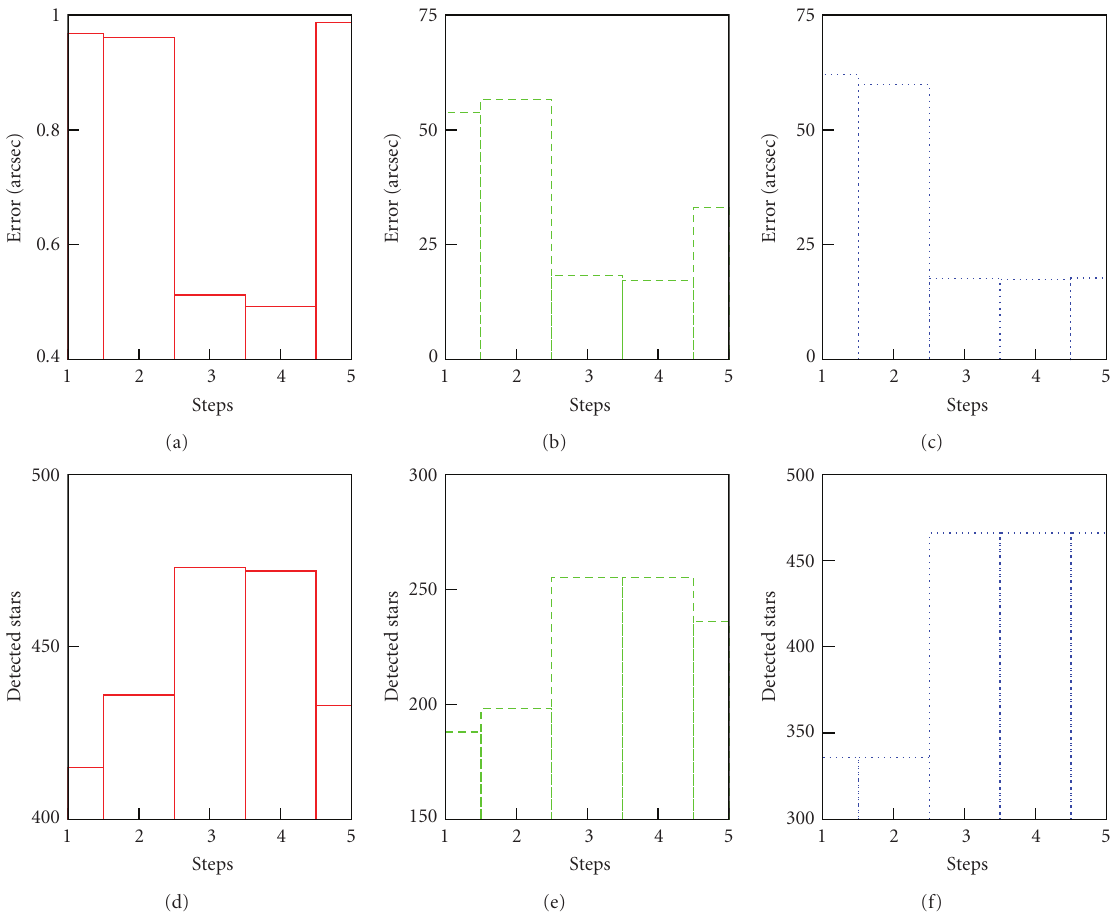
Figure 5: Average error (a, b, c) and the number of identified stars (d, e, f) as functions of the degree of the polynomial used. The dependences are shown for three di ff erent optical systems. Red (a) and (d) Rigter-Slefogt (MASTER) with a field of view of 6deg 2 , Nikkor 50mm f/ 1 . 2 (b) and (e) with a field of view of 1000 deg 2 , and Nikkor 50mm f/ 1 . 4 (c) and (f) with a field of view of 1000 deg 2 . The histograms are based on arbitrary frames from various sky areas. A third-to-fourth-degree polynomial approximation can be seen to provide optimum solution (95–99 percent of stars are identified with the minimum average error). A more detailed analysis shows that the third- degree fit yields slightly better results. That is logical, because most of the known aberrations (e.g., distortion) depend on the third power of radial